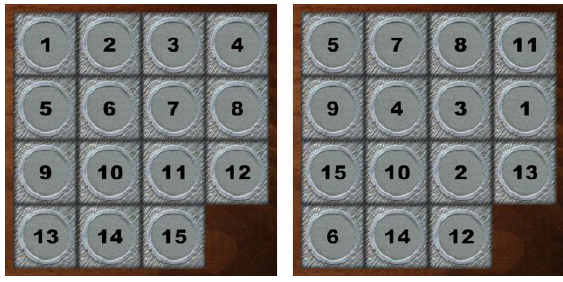
Figure 1. The solved 15-puzzle ( left ), and a random configuration ( right